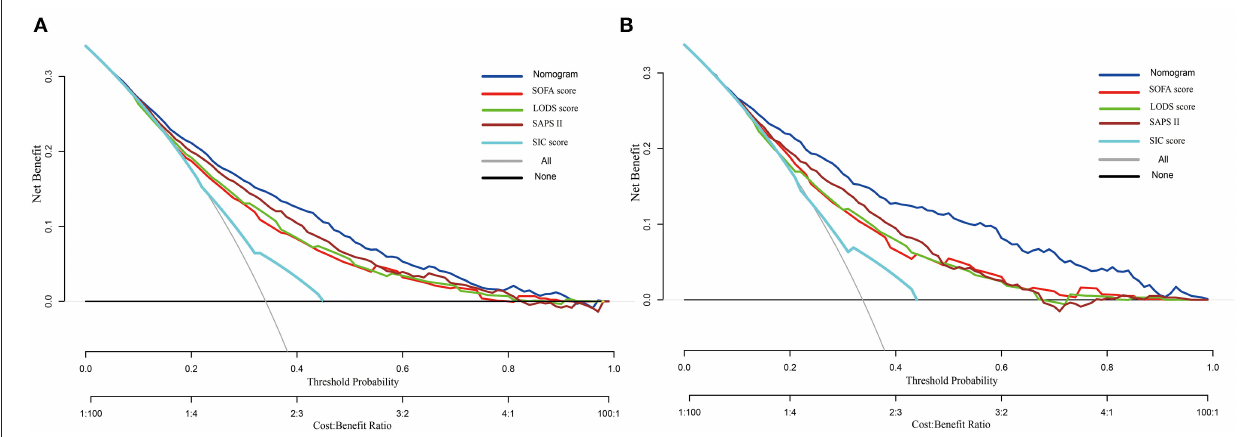
FIGURE 4 | Decision curve analysis of the nomogram, SOFA, LODS, SAPS II and SIC. (A) Training set; (B) Validation